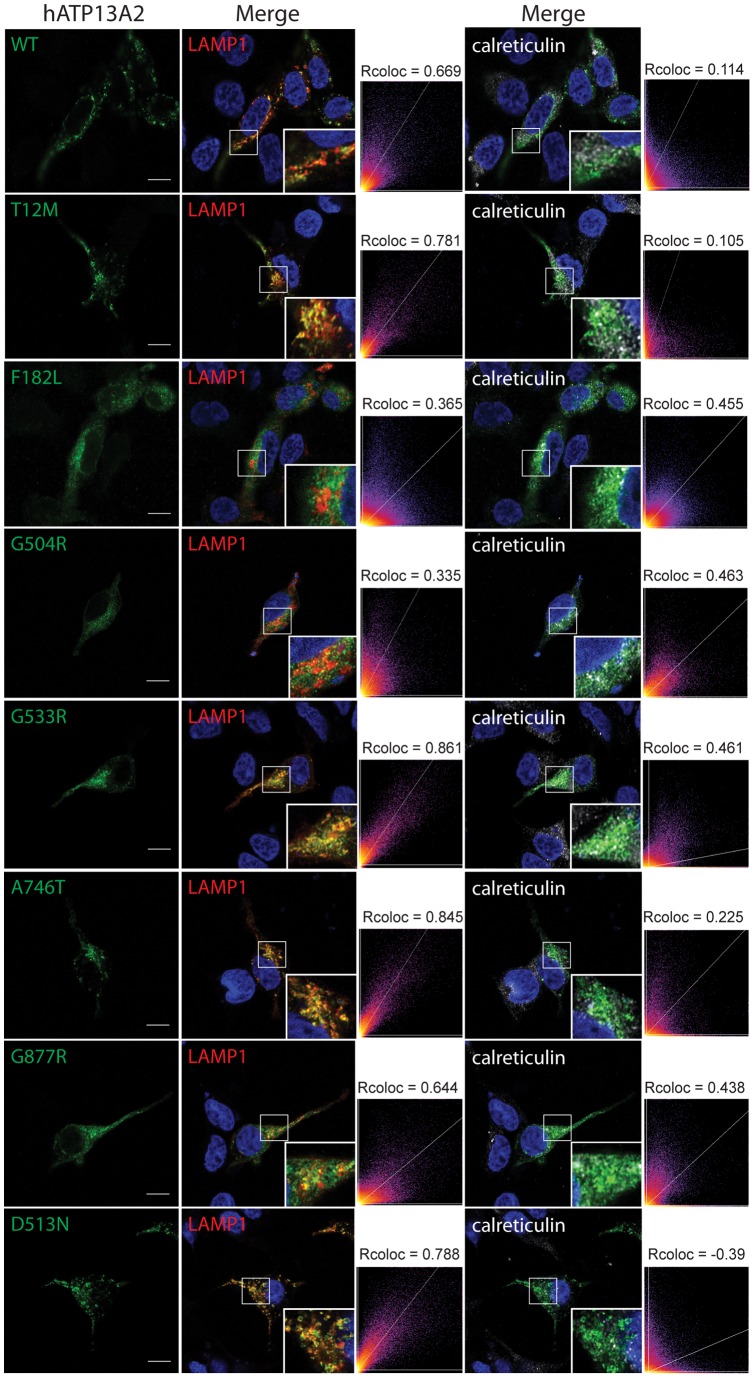
Homozygous F182L and G504R mutations induce the mislocalization of ATP13A2 to the endoplasmic reticulum.Confocal fluorescence microscopy reveals the enhanced co-localization of F182L and G504R mutant ATP13A2 with the endoplasmic reticulum marker, calreticulin, and reduced co-localization with lysosomes (LAMP1-RFP), compared to WT or missense mutant (T12M, D513N, G533R, A746T or G877R) ATP13A2 transiently expressed in human SH-SY5Y neural cells. Staining for V5-tagged human ATP13A2 (V5, green), LAMP1-RFP (red), calreticulin (gray) and nuclei (DAPI, blue) are indicated. Cytofluorograms and correlation coefficients (Rcoloc) indicate the extent of co-localization of ATP13A2 variants with lysosomal (LAMP1) and ER (calreticulin) markers. Confocal images are taken from a single z-plane at 0.15 µm thickness. Images are representative of at least two independent transfection experiments. Scale bar: 10 µm.